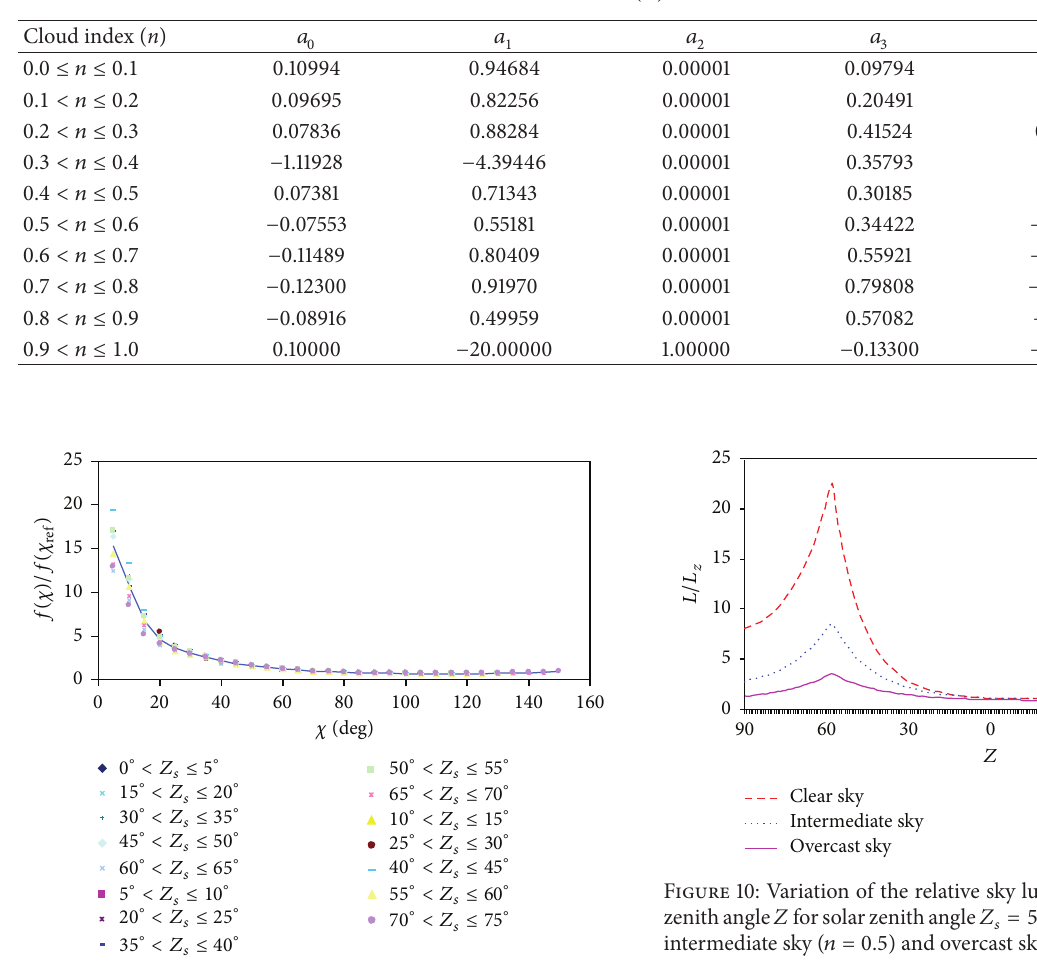
Table 3: Values of the coefficients of (11). 𝑅 2 is coefficient of determination.